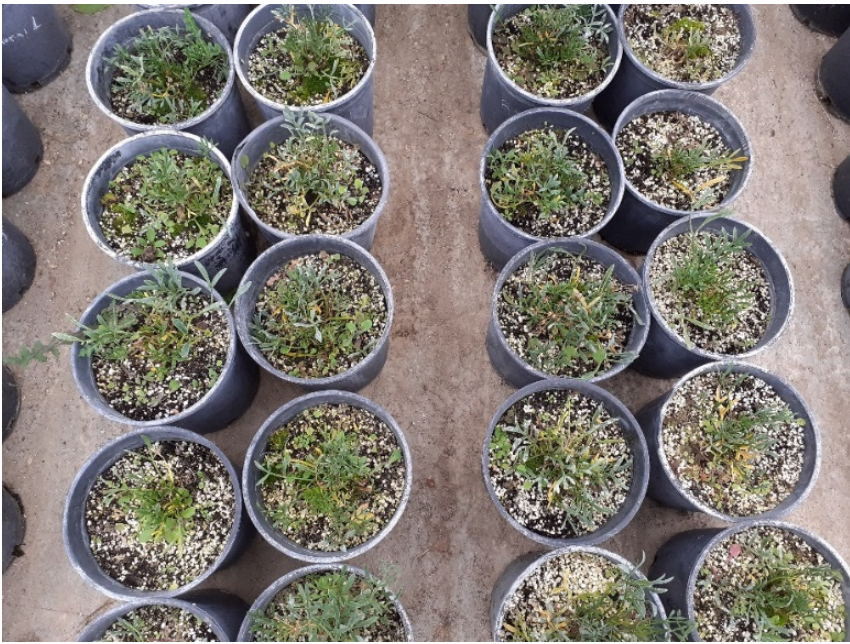
Figure 2. Pot cultivation of sea fennel under greenhouse conditions at the experimental farm of University of Thessaly.